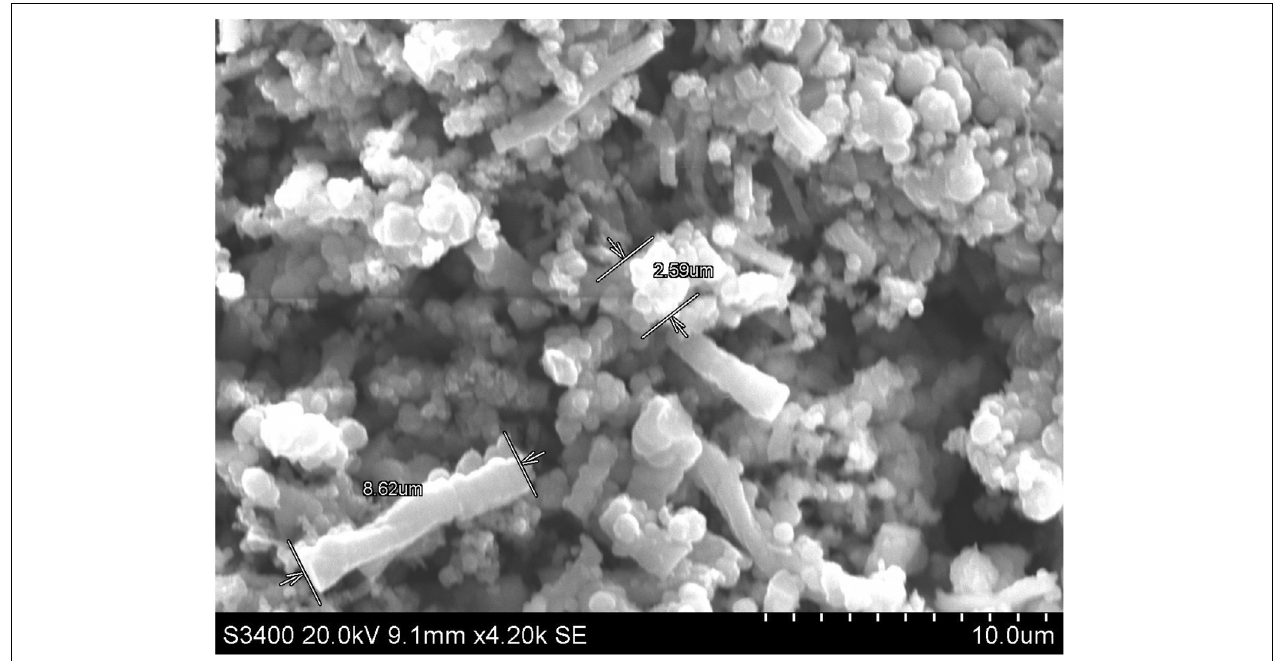
FIGURE 1 | Particle morphology of fresh ochre under scanning electron microscope.